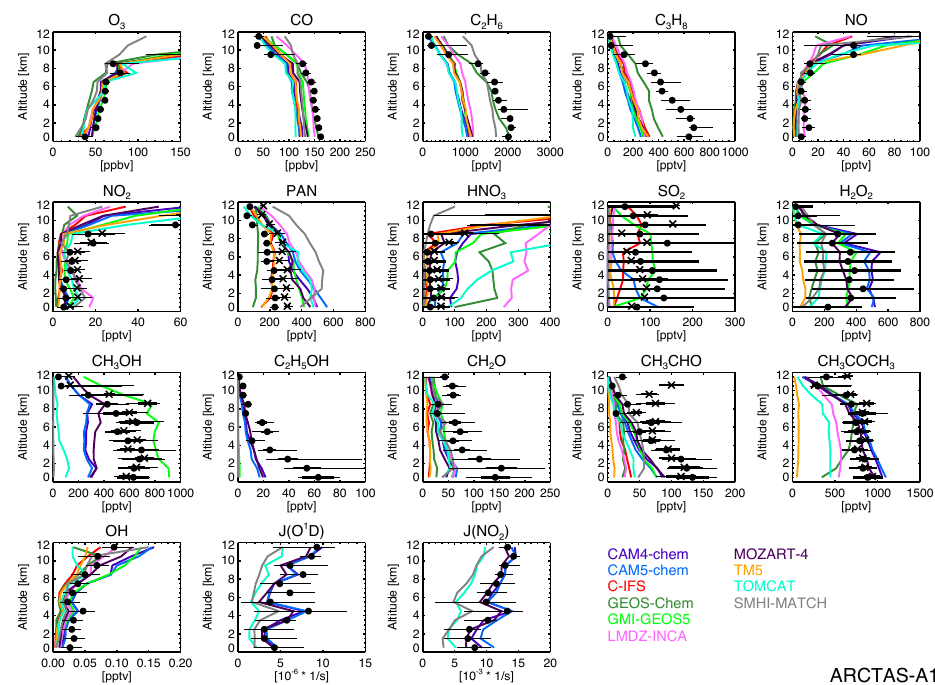
Figure 16. Comparison of model results interpolated to flight tracks of observations during the first four DC-8 flights of ARCTAS-A. Each profile is the median of 1km altitude bins. Medians of observations in each 1km altitude bin are shown as black circles and crosses (if a second measurement exists for a given parameter). Thick error bars represent the measurement uncertainty; thin error bars span inter- quartile range of all observations.